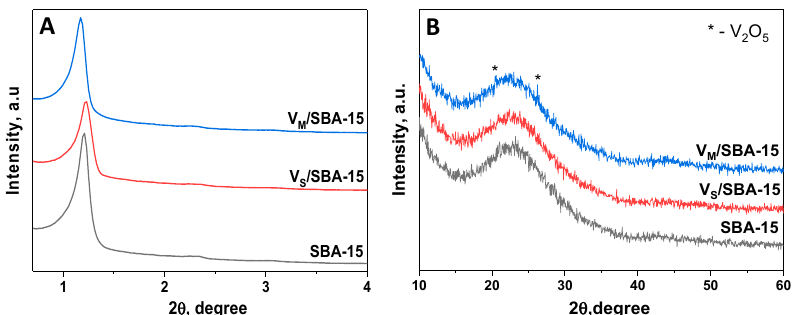
Figure 1. Small-angle ( A ) and wide-angle ( B ) XRD patterns of SBA-15 before and after modification with vanadium precursors.